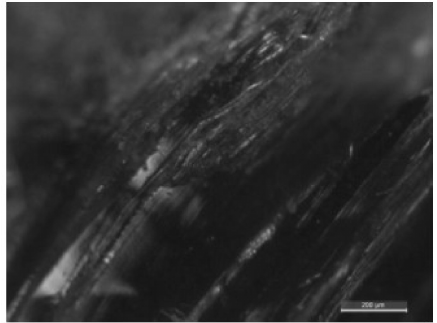
Figure 10. Microscopic image of panel 11 showing fibre loss on the first layer of the